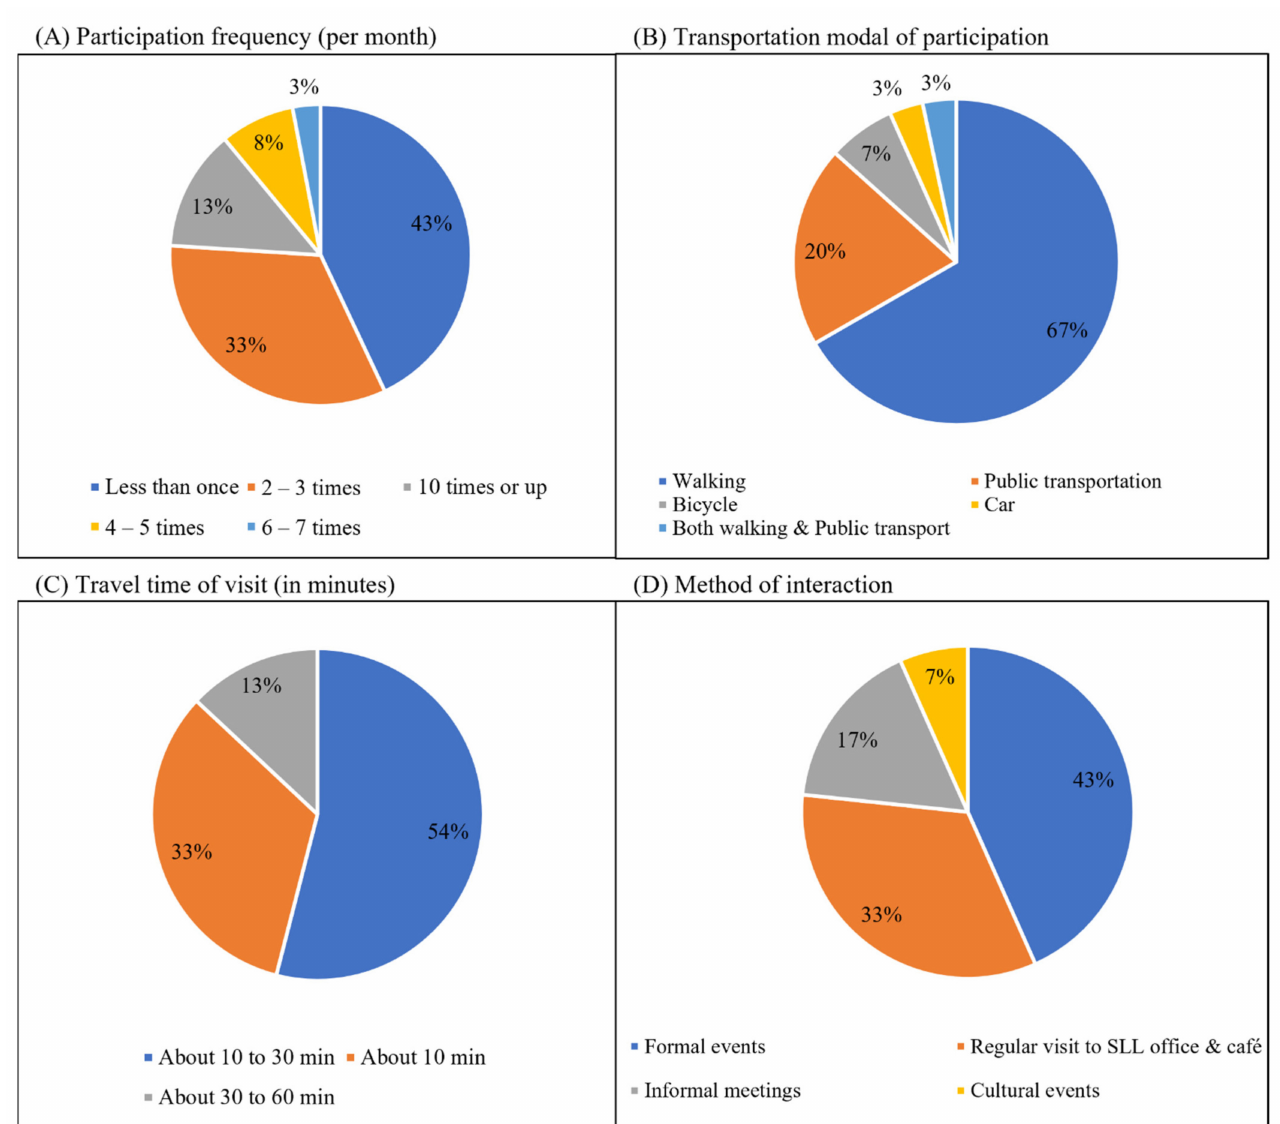
Figure 5. Descriptive data of the